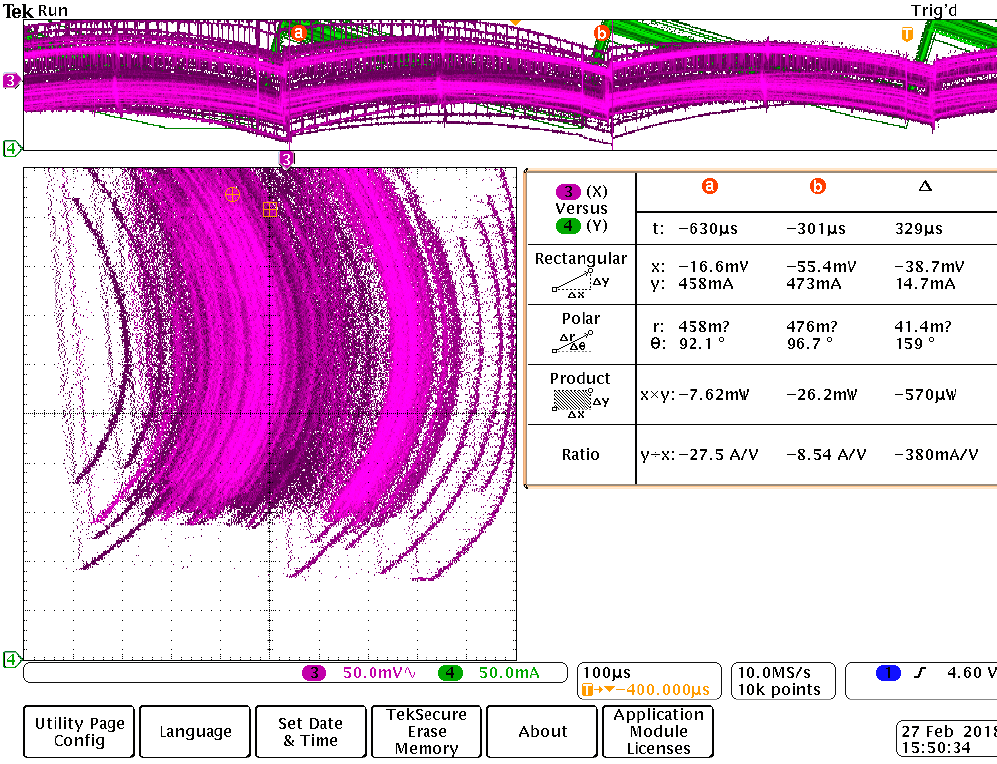
Figure 19. Chaotic operation of the converter corresponding to V g = 17.80 V.